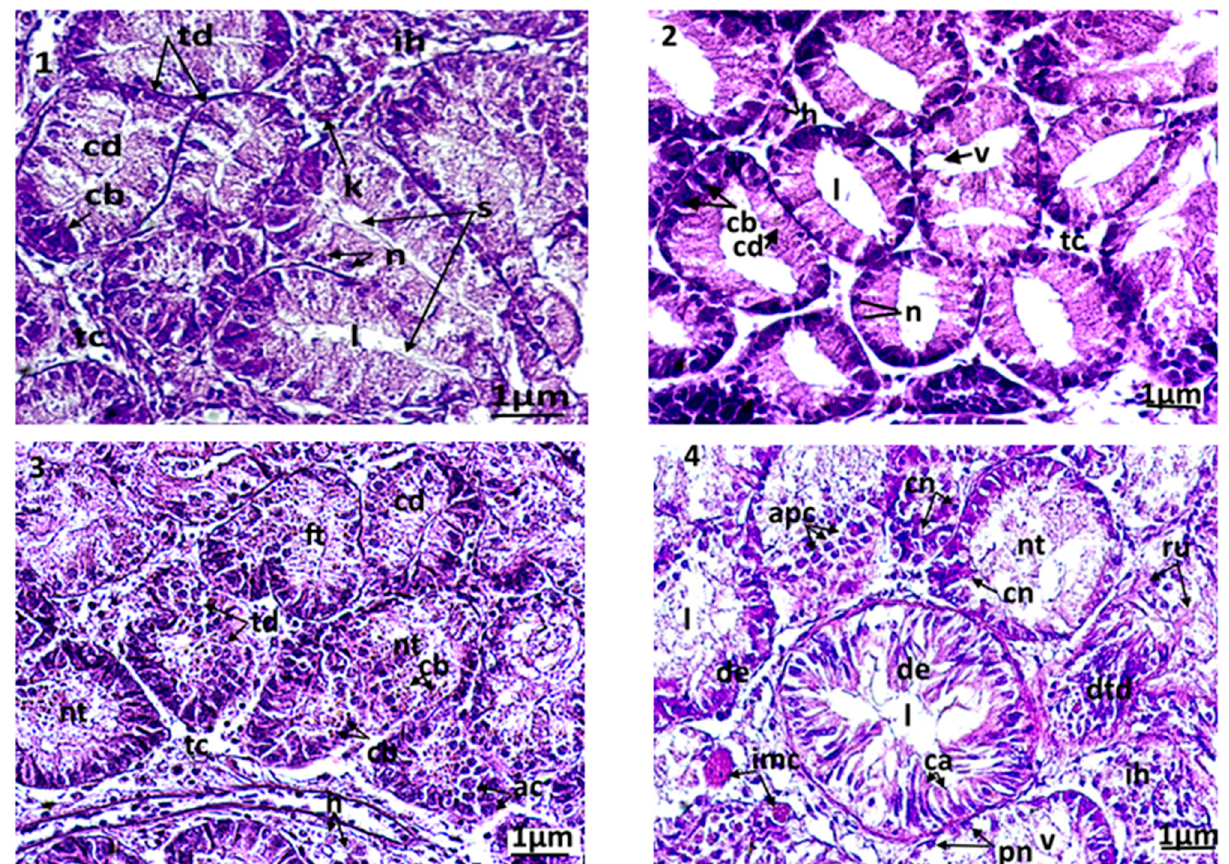
Figure 4. Microphotography of digestive tubules. ( 1 ): control clams; ( 2 ): clam exposed to